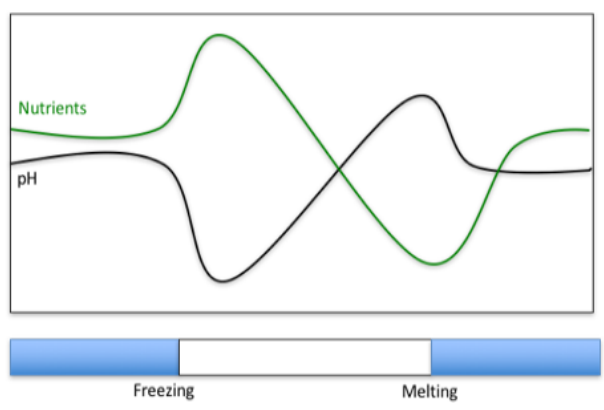
Figure 1. Generalized annual succession of pH and nutrient con- centration in sea ice brine ecosystems in response to ice formation in winter and melting in spring. On the bar at the bottom of the fig- ure, blue represents open water and white represents the presence of ice. “Nutrients” is a general trend showing the concentration of inorganic